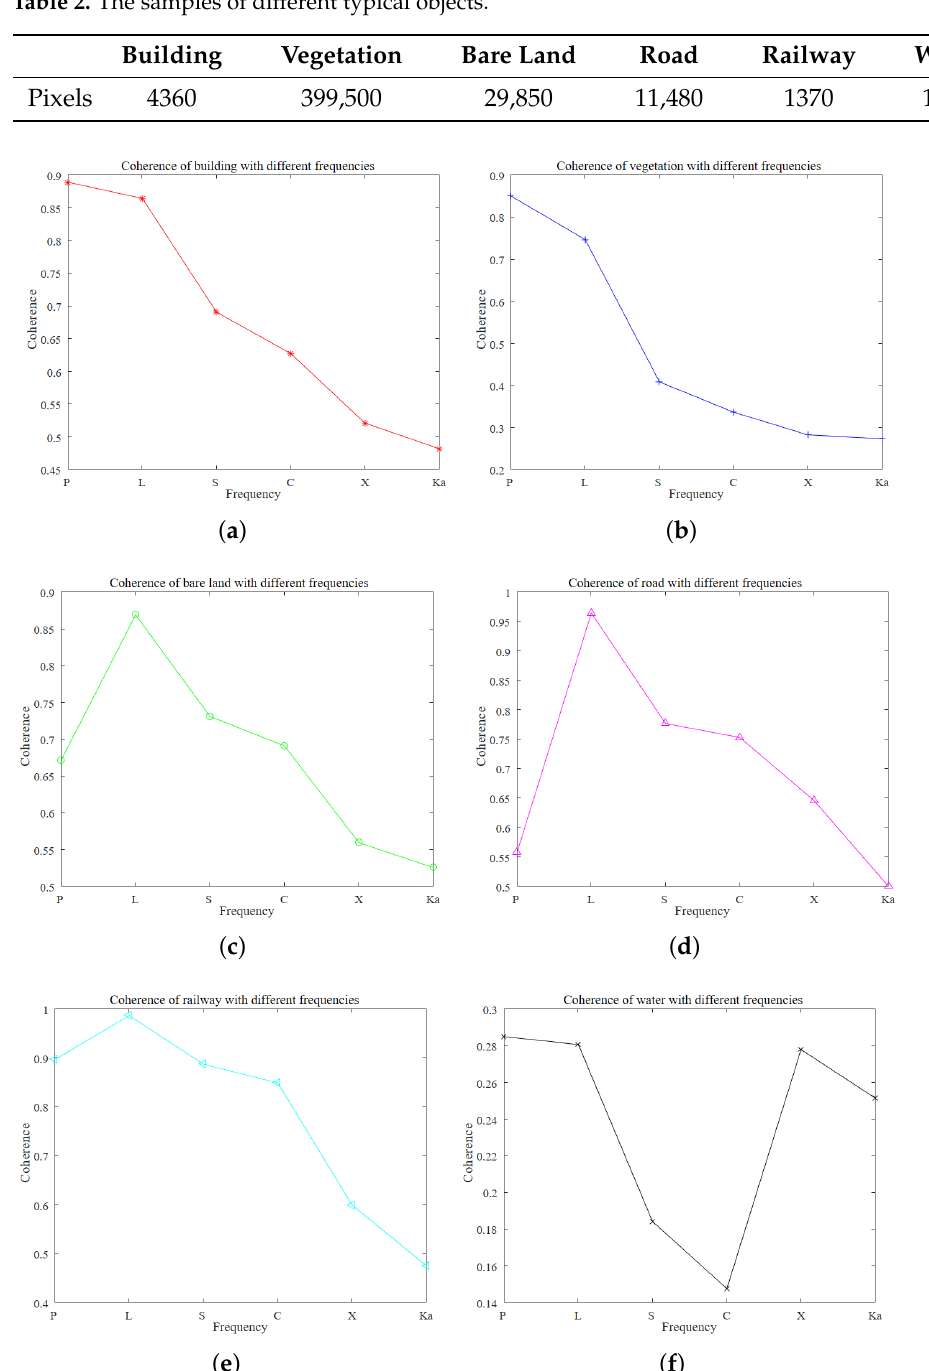
Table 2. The samples of different typical objects.